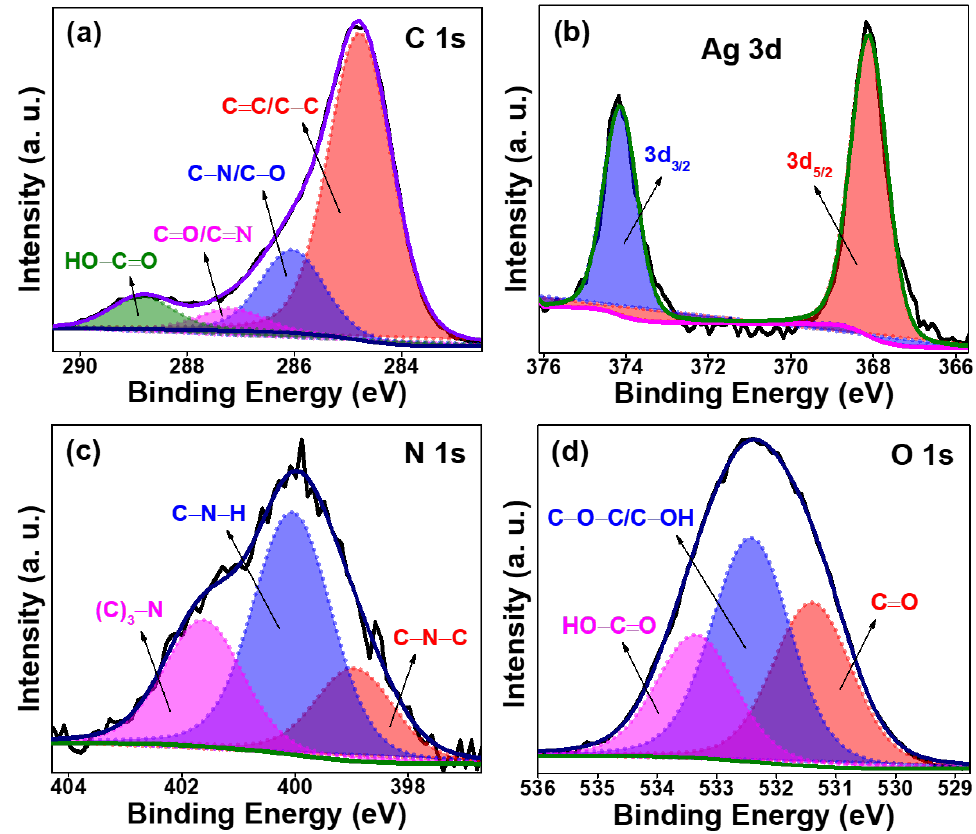
Figure 4. High-resolution XPS spectra ( a ) C 1 s, ( b ) Ag 3 d, ( c ) N 1 s, and ( d ) O 1 s of the synthesized CDs@AgNPs.